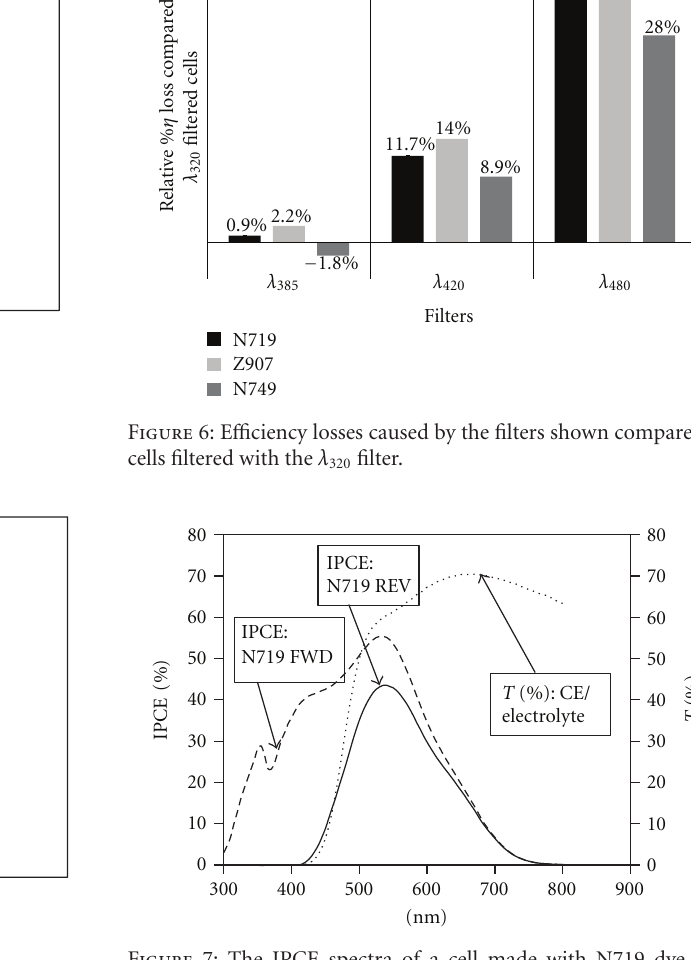
Figure 7: The IPCE spectra of a cell made with N719 dye and measured in both forward (FWD) and reverse (REV)